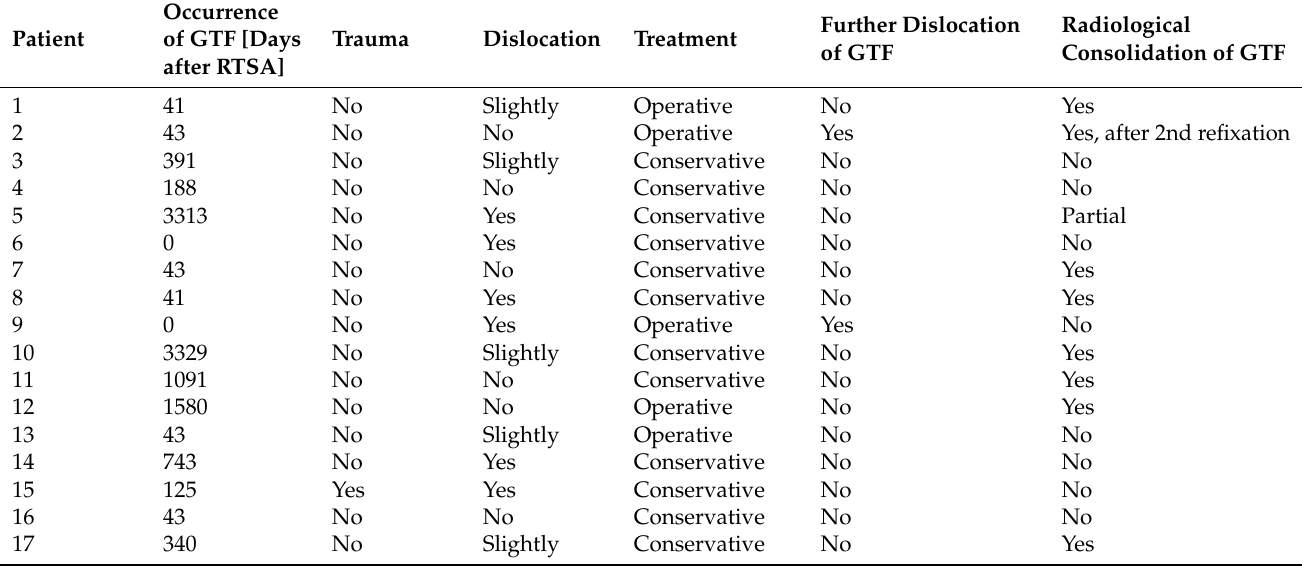
Table 2. GTF-related